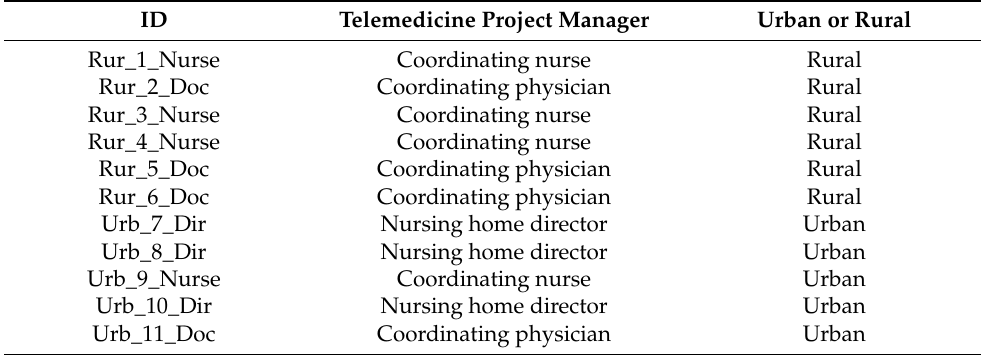
Table 4. Characteristics of the telemedicine project managers interviewed for the study about nursing homes and Troyes hospital in France between 2018 and 2021.